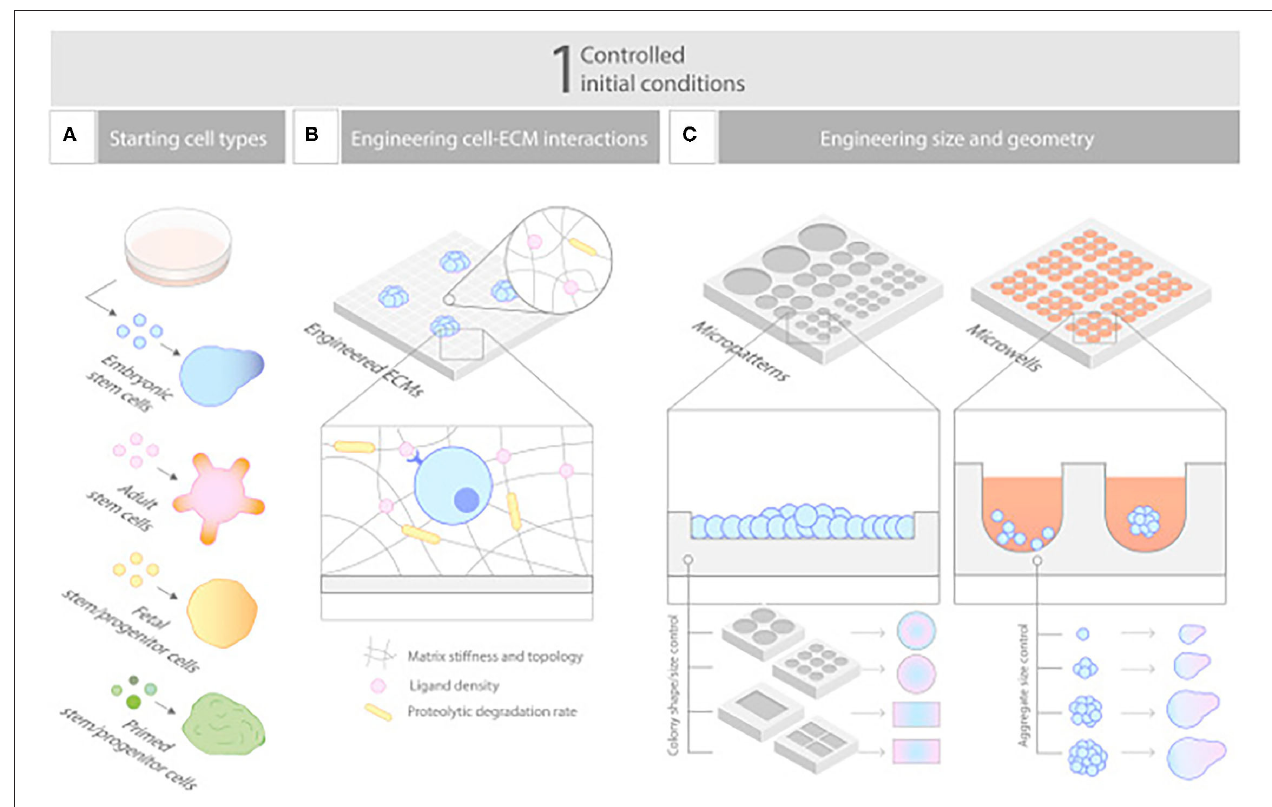
FIGURE 4 | Controlling initial conditions. (A–C) Carefully designed starting conditions are critical for robust organoid formation, and these include (A) choosing the nature of the cells, (B) controlling their aggregation to a defined size and shape, and (C) engineering their environment to empower their ability to self-organize. Reprinted from Brassard and Lutolf (